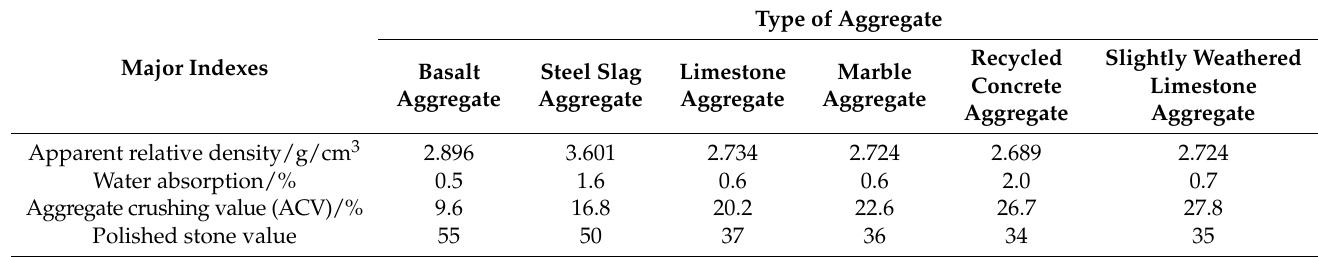
Table 1. Basic properties of different types of aggregate.